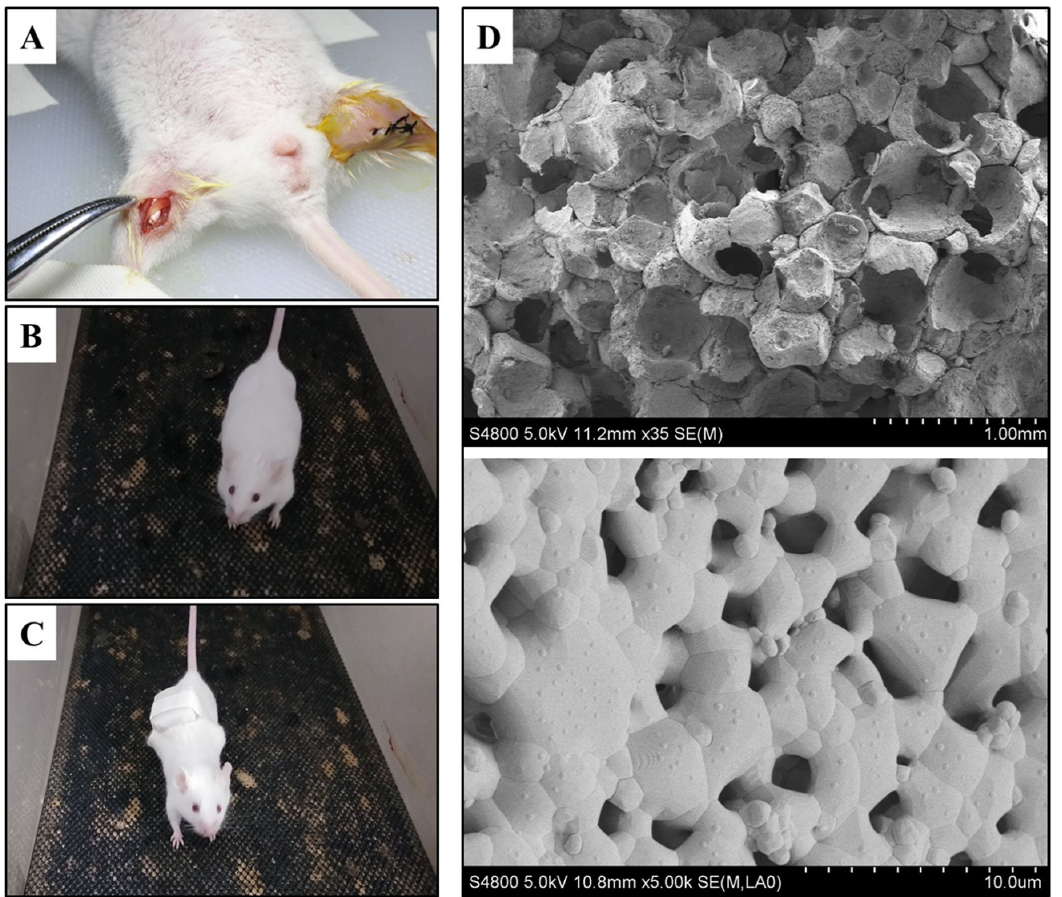
Figure 1. ( A ) The hydroxyapatite/β-tricalcium phosphate (HA/β-TCP) biomaterial transplanted site (left side) and suturing during surgery (right side). ( B ) Running mouse of group 2 on the treadmill. ( C ) Weight-bearing running mouse with rubber of group 3 on the treadmill. ( D ) The micropores (upper side, bar: 1 mm) and super-micropores (downside, bar: 10 μ m) of HA/β-TCP biomaterials scanned by scanning electron microscopy (SEM).